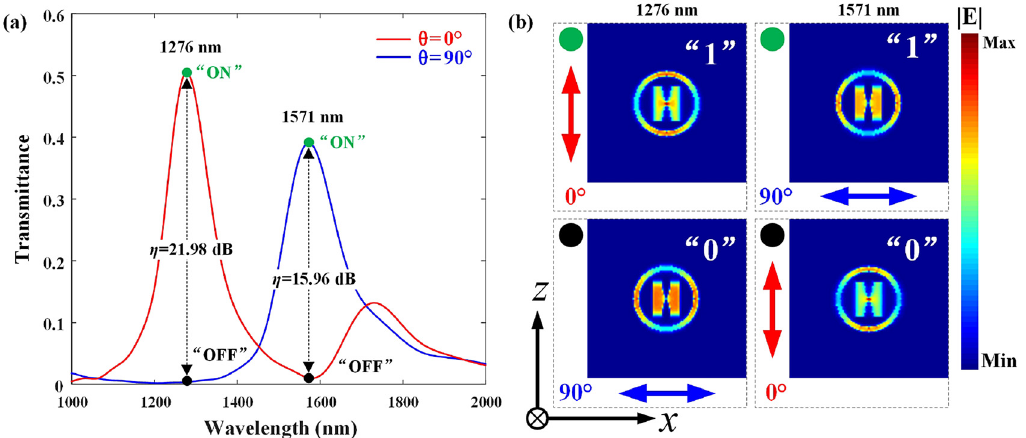
Figure 4: The polarization-dependent dual-wavelength passive plasmonic switching and 1-bit digital metasurface. (a) The polarization-dependent dual-wavelength passive plasmonic switching in the near-infrared region, with the ON/OFF ratio being 21.98 and 15.96 dB at a wavelength of 1276 and 1571 nm, respectively. (b) The 1-bit digital metasurface can be obtained by encoding the elements “ 1 ” and “ 0 ” in two ways at the related wavelengths. The four subplots show the polarization of the incident light and the related E - fi eld distributions. The parameters of the unit cells of the hybrid metasurface are set as R 1 = 122.5 nm, D = 20 nm, L = 130 nm, W = 100 nm, a p = 1, and b p = 5, and the other parameters are the same as Figure